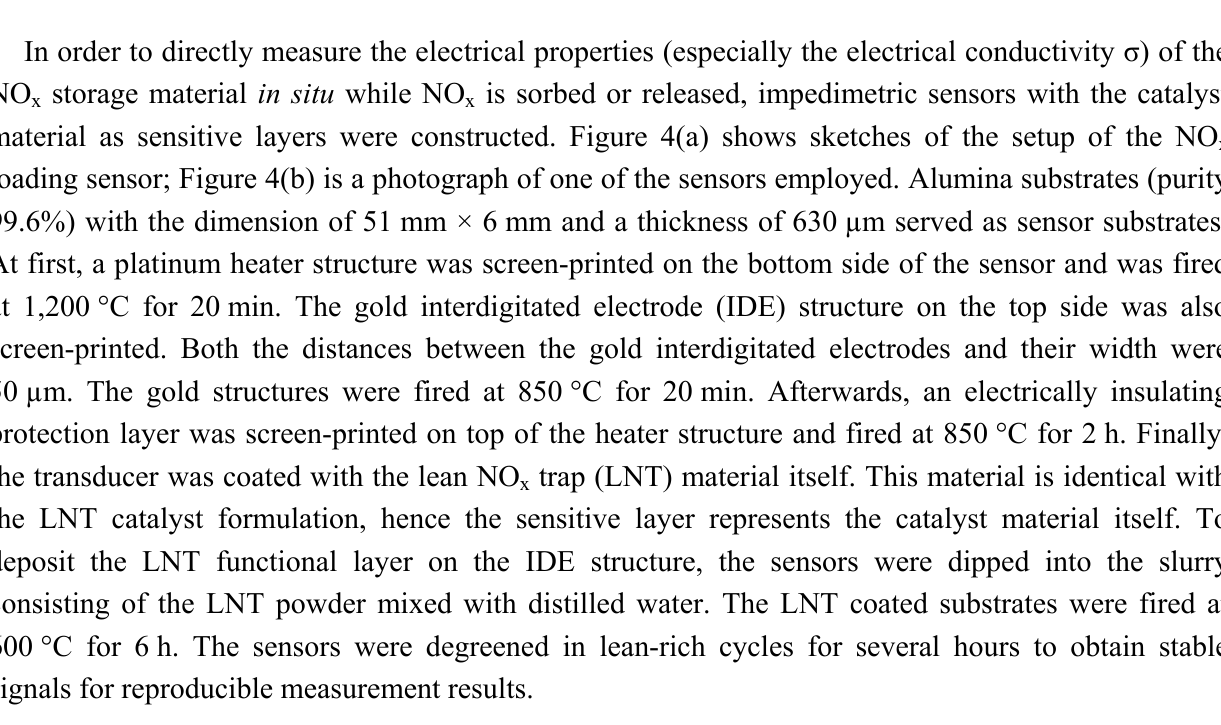
Figure 4. Setup of a single impedimetric sensor. (a) Sketches of different perspectives of the sensor element consisting of an alumina substrate, interdigital electrodes and a heater structure coated with the sensitive layer. Please note that the functional film on both sides is identical with the LNT material of the used catalyst. (b) Photograph of the top side of a